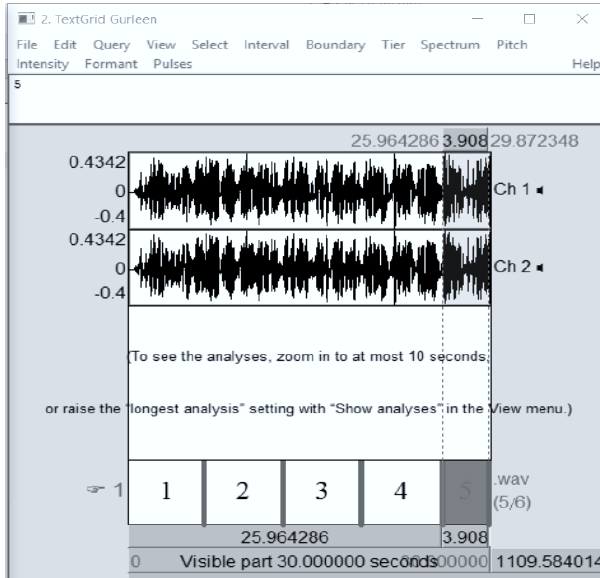
Figure 3. Segmentation of audio file in current ASR system.